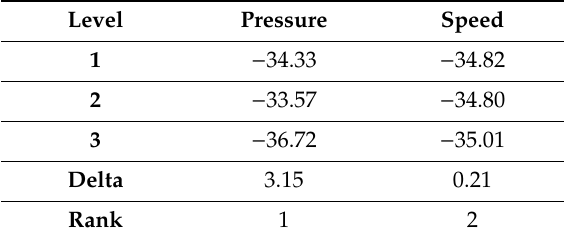
Table 5. Response table for S/N ratio.